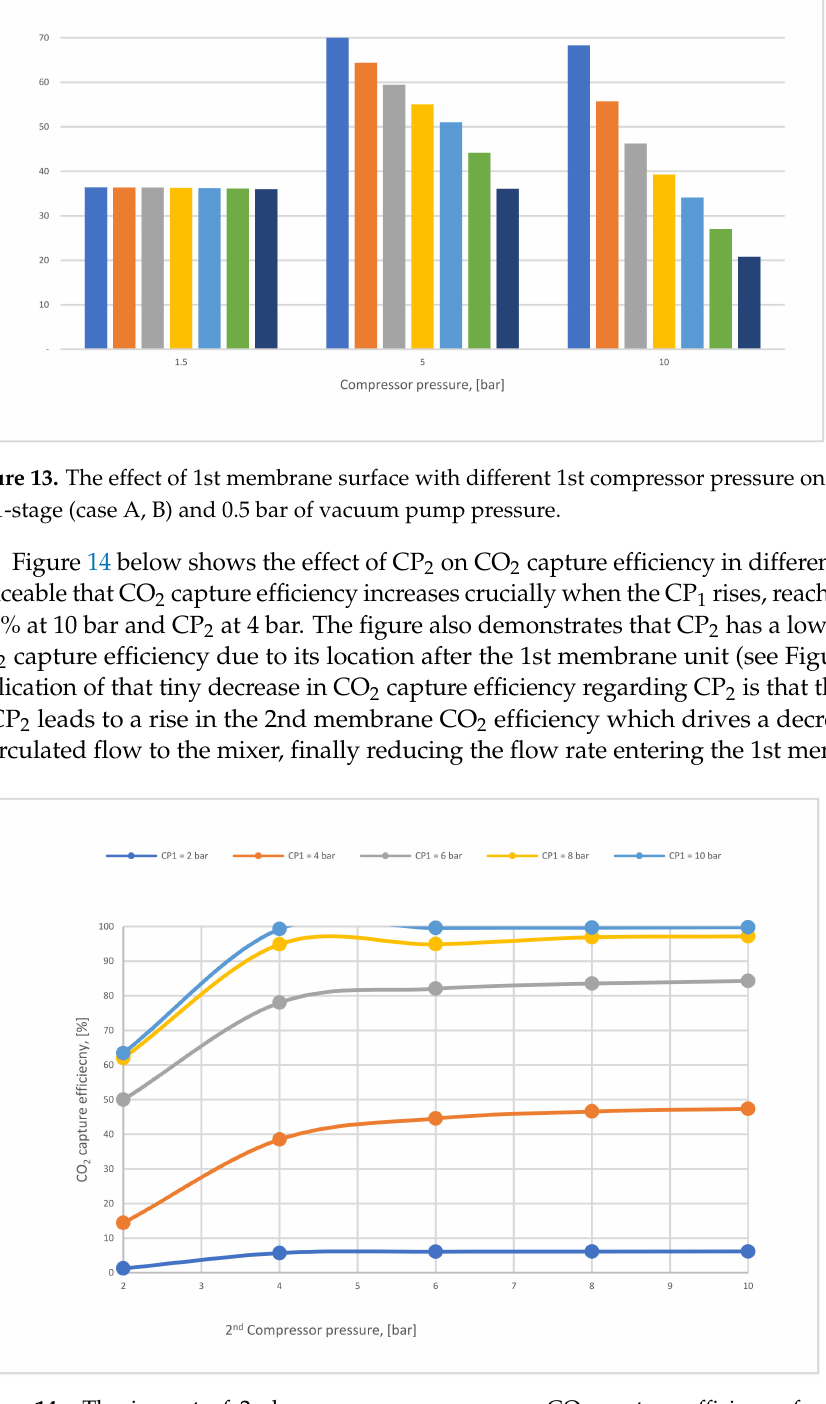
Figure 14. The impact of 2nd compressor pressure on CO 2 capture efficiency for 2-stages at 600,000 and 40,000 m 2 (1st membrane surface and 2nd membrane surface,